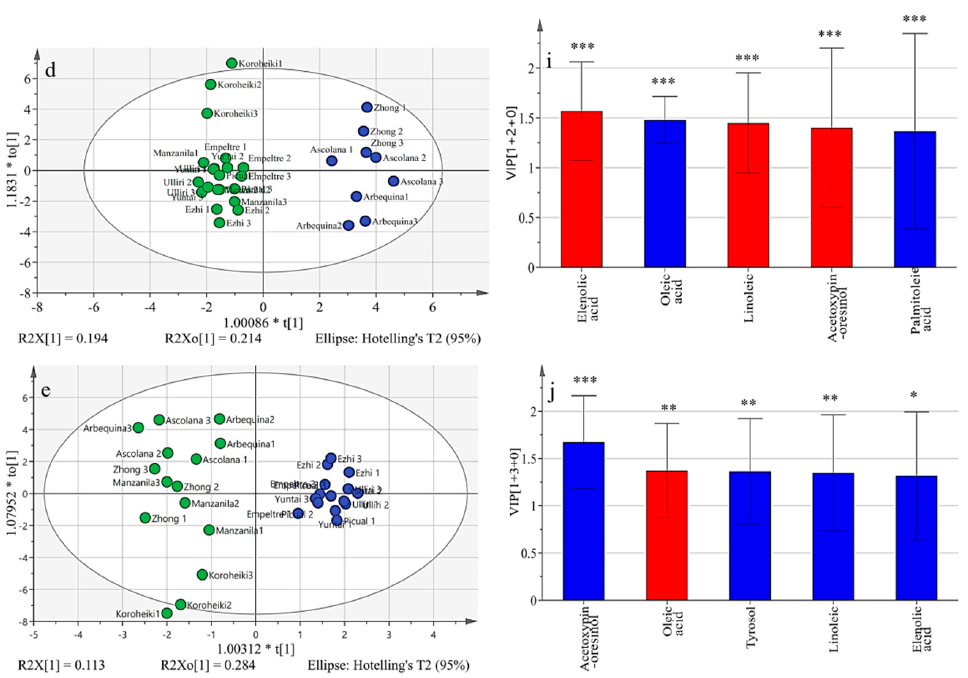
Figure 3. OPLS-DA models: ten varieties ( a ), ‘ Koroneiki ’ vs others ( b ), ‘ Manzanilla ’ vs others ( c ), ‘ Ascolana tenera, Arbequina and Zhongshan24 ’ vs others ( d ),’ Ezhi8, Ulliri Bardhe, Empeltre, Yuntai14 and Picual ’ vs others ( e ); summary of the first five variables of the important differential variables in each left separation group, respectively ( f – j ). Red indicates a higher level and blue indicates a lower level. Green does not involve in level expression. “***”, p < 0.001, “**”, p < 0.01, “*”, p < 0.05. 1 Extractability index (EI); total phenolic content (TPP).